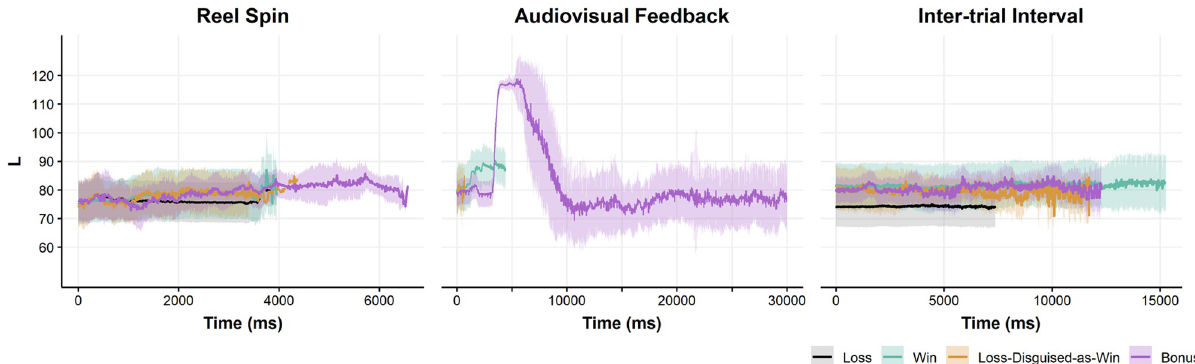
Fig 5. Ice Empress slot machine screen luminance by outcome phase. Average screen luminance (L) component from CIELAB color space. L range = 0–255, Audiovisual Feedback Time ranged from 0–176,220 ms; a narrower range limited at 30,000 ms is presented for easier inspection. Ribbons represent one standard deviation above and below the mean of 3060 loss (82.0%), 406 win (10.9%), 229 loss-disguised-as-win (6.1%), and 36 bonus outcomes (1.0%) at a given point in Time.